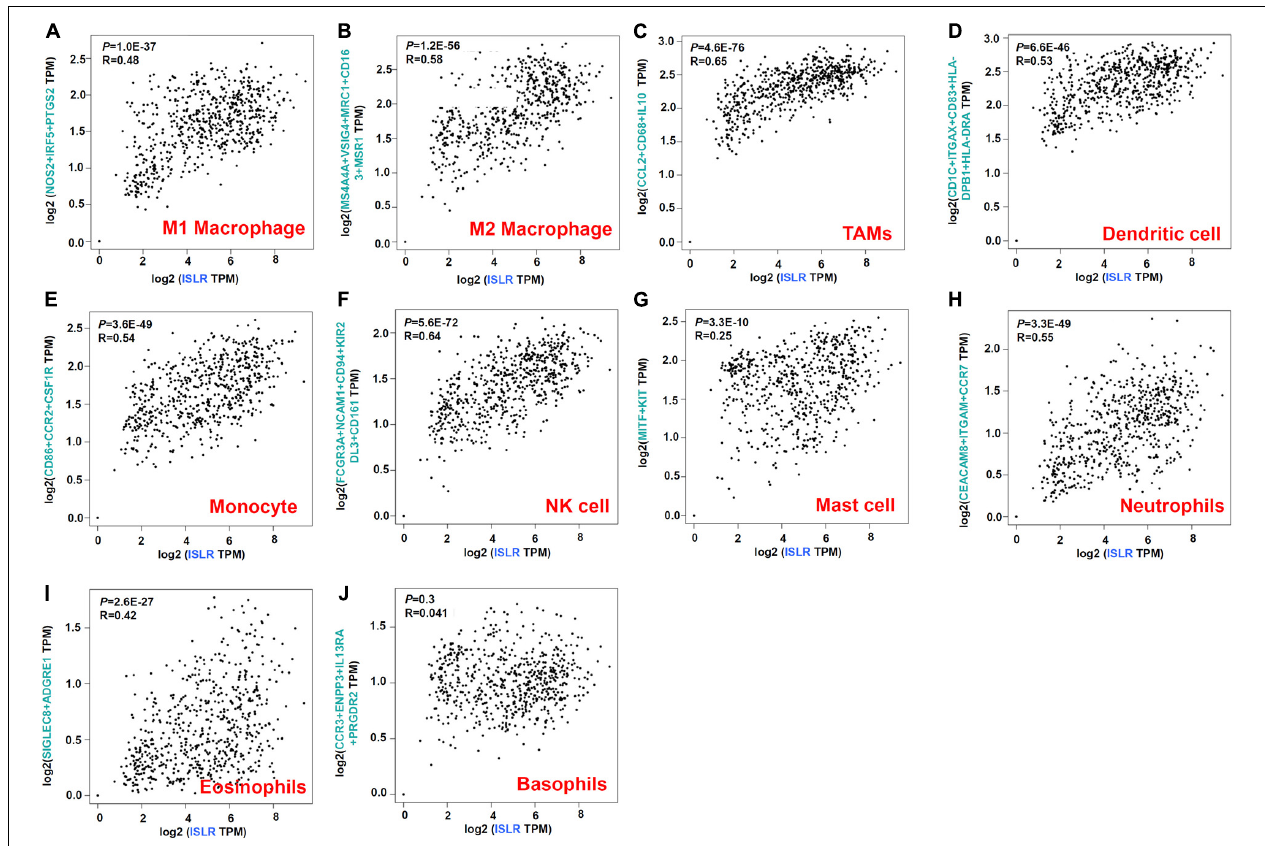
FIGURE 5 | Correlation between ISLR expression and markers of immune cells as analyzed through GEPIA2. (A) M1 macrophages; (B) M2 macrophages; (C) TAMs; (D) dendritic cells; (E) monocytes; (F) NK cells; (G) mast cells; (H) neutrophils; (I) eosinophils; (J)